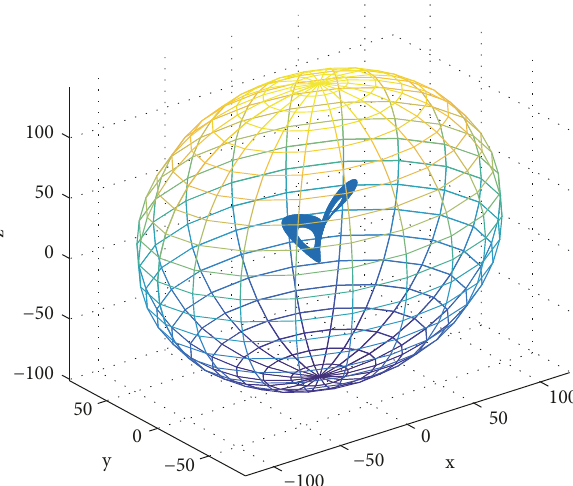
Figure 2: Localization of chaotic attractor of system (2) in xOyz space defined by Ω 1,1